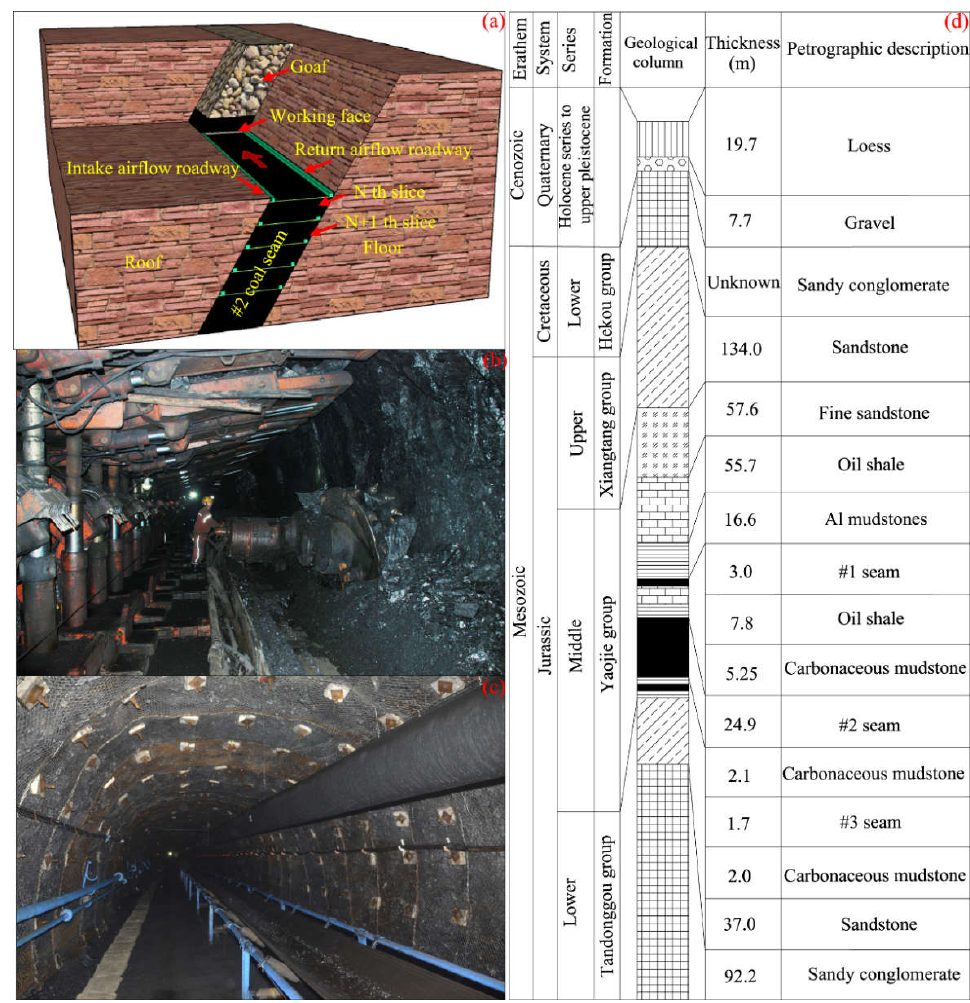
Figure 2. Mining method and generalized stratigraphic column in the Yaojie No. 3 coal mine: ( a ) schematic view of the HFMTCSC mining method; ( b ) mining condition; ( c ) coal roadway support condition and ( d ) the stratigraphic column.